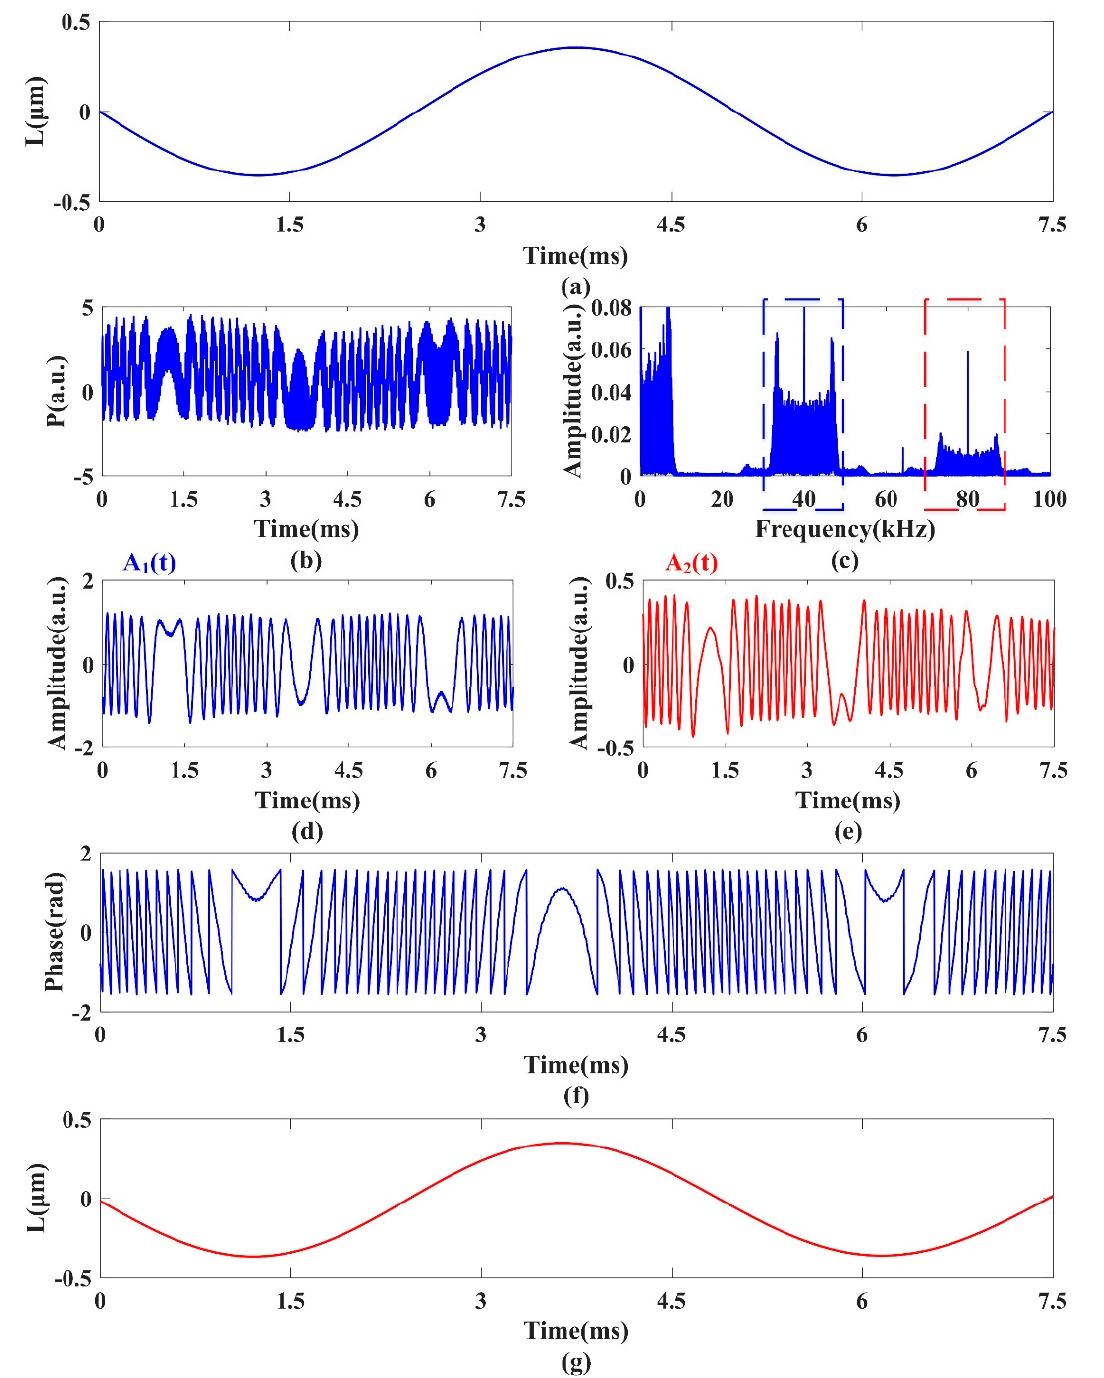
Figure 6. Experimental results with the driving voltage 0.8 V of target. ( a ) Vibration displacement of the outer objective. ( b ) Phase-modulated SMI signal. ( c ) Frequency spectrum of SMI signal. ( d ) Amplitude of the first harmonic. ( e ) Amplitude of the second harmonic. ( f ) Wrapped phase from SMI. ( g ) Reconstructed displacement.